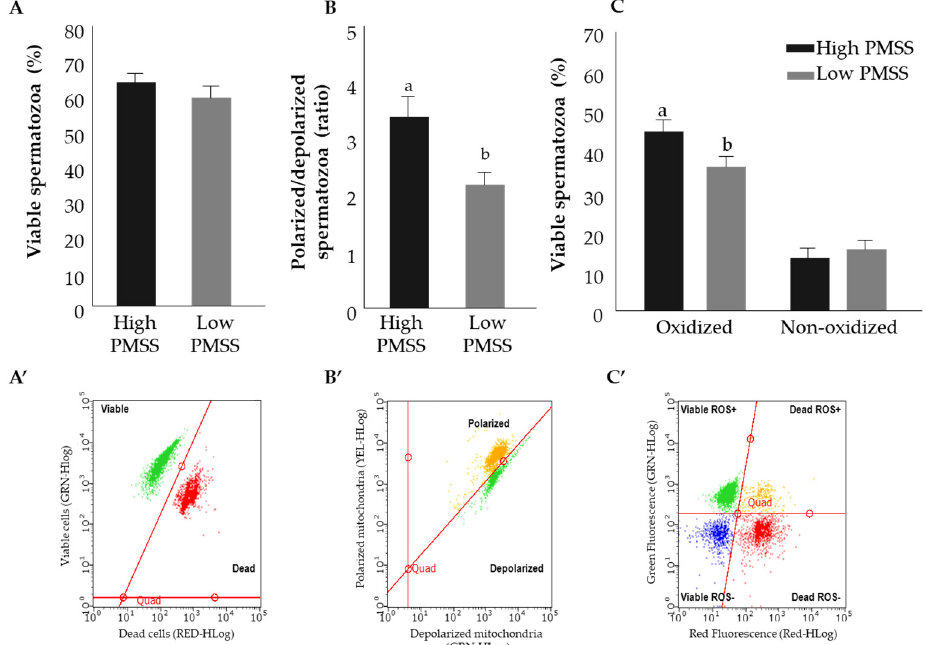
Figure 5. Structural characteristics of fresh spermatozoa in the high and low progressively motile spermatozoa’s survival (PMSS) groups. Presented are the proportion of viable spermatozoa out of total spermatozoa ( A , A’ , green); mitochondrial membrane potential expressed as the ratio of polarized to depolarized membrane ( B , B’ ). Different letters above columns indicate significant differences between groups at p ≤ 0.005 . The proportions of oxidized and nonoxidized viable sperma- tozoa are presented ( C , C’ ). Data are presented as mean + SEM. Different letters above columns indicate significant differ- ences between groups for oxidized viable spermatozoa at p ≤ 0.005 . A’ – C’ are scatter plot representations of the results, expressed as a fluorescence intensity. GRN-HLog, YEL-HLog or RED-HLog indicate the green, yellow or red highest flu- orescence intensity on log scale, respectively.